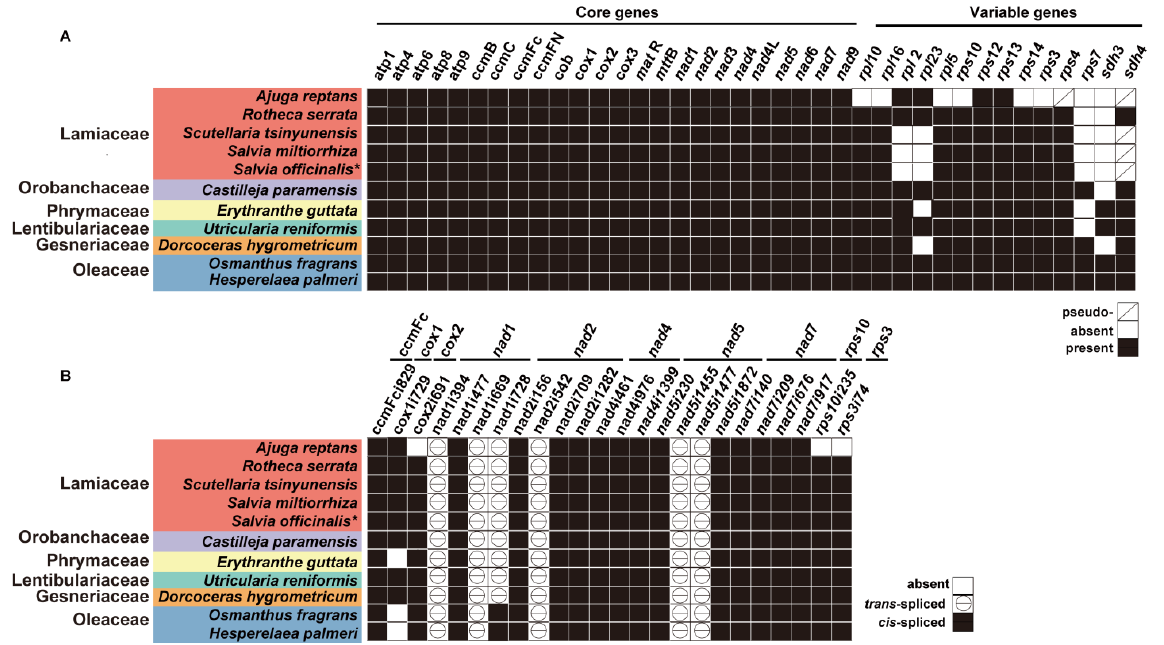
Figure 5. Heatmaps showing the PCG contents ( A ) and intron contents ( B ) in eleven sequenced Lamiales mitogenomes. Each column represents a gene in ( A ) and an intron in ( B ). Each row repre- sents a species. The gene and intron names are shown above the heatmaps. The Latin names for each species and the family they belong to are shown to the left of the heatmap. The introns are named according to a prior scheme [52]. The mitogenome generated in this study was labeled with “*” . The different colored and patterned squares in the figures are explained below ( A ) and to the right of ( B ) the heatmaps.